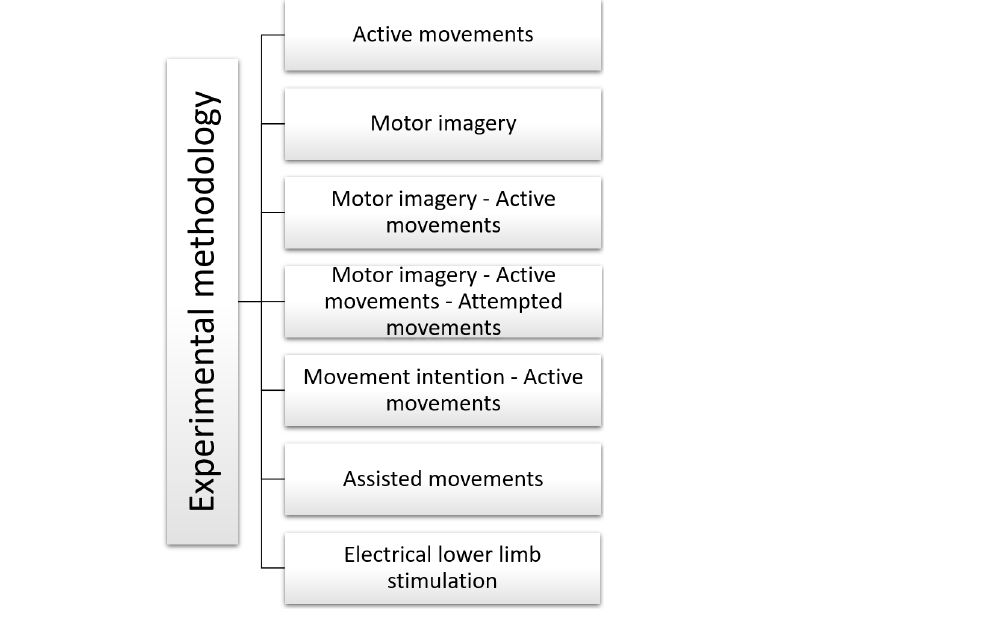
Figure 7. High-level taxonomy and related works for the experimental methodologies for data ac- quisition. Associated bibliographic references: active movements [59,67,72–74], motor imagery [61,63,64,70,75,78], motor imagery–active movements [71,76,77,79], motor imagery–active movements–attempted movements [80], movement intention–active movements [60,66,68,69], as- sisted movements [62], and electrical lower limb stimulation